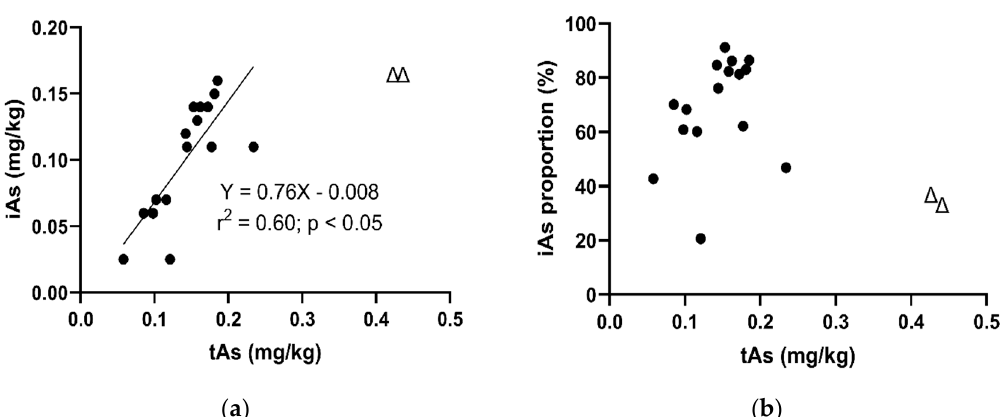
Figure 2. Relationships between ( a ) inorganic arsenic (iAs) and total arsenic (tAs) concentrations and ( b ) iAs as a proportion of tAs and tAs concentration for rice-based infant foods in Australia. Symbol Δ represents sample outlier and was not included in the linear regression analysis.